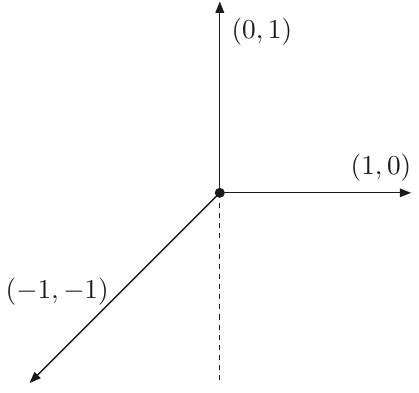
Figure 1 . A toric fan of P 2 can be obtained by removing the edge (0 , − 1) from the toric fan of dP 1